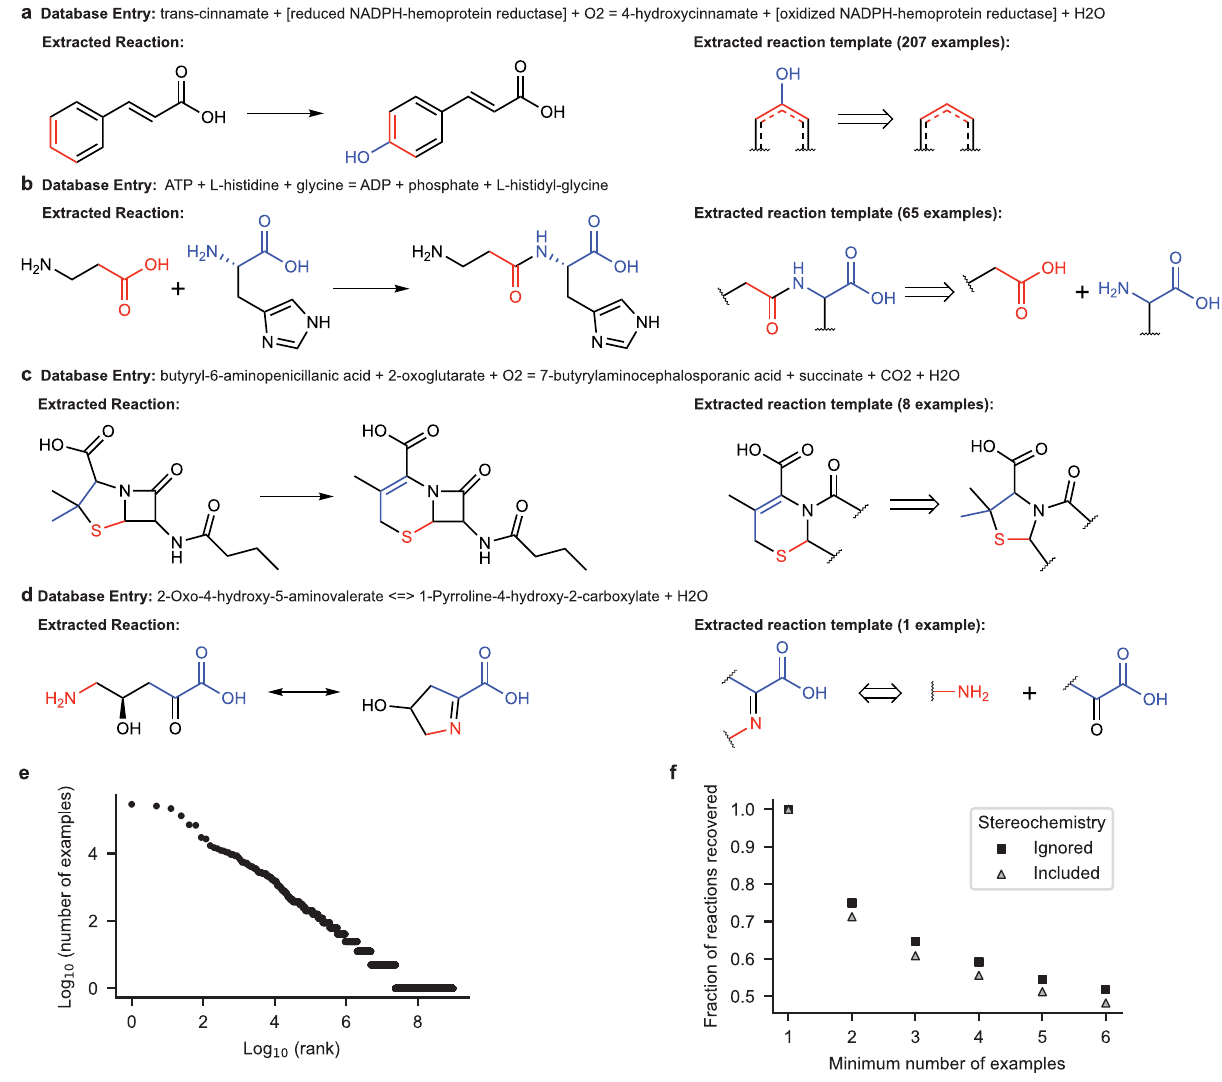
Fig. 2 | Reaction templates automatically extracted from the BKMS biochem- ical reaction database. a – d Examples of reactions and reaction templates extractedfromtheBKMSdatabase.Cofactorreactant-productpairs(e.g.,SAMand SAH)were automatically identi fi ed and removed. Chemical names were converted to SMILES strings, shown here by molecular structures. Reaction templates were automatically extracted from the atom-mapped SMILES string as SMARTS strings,